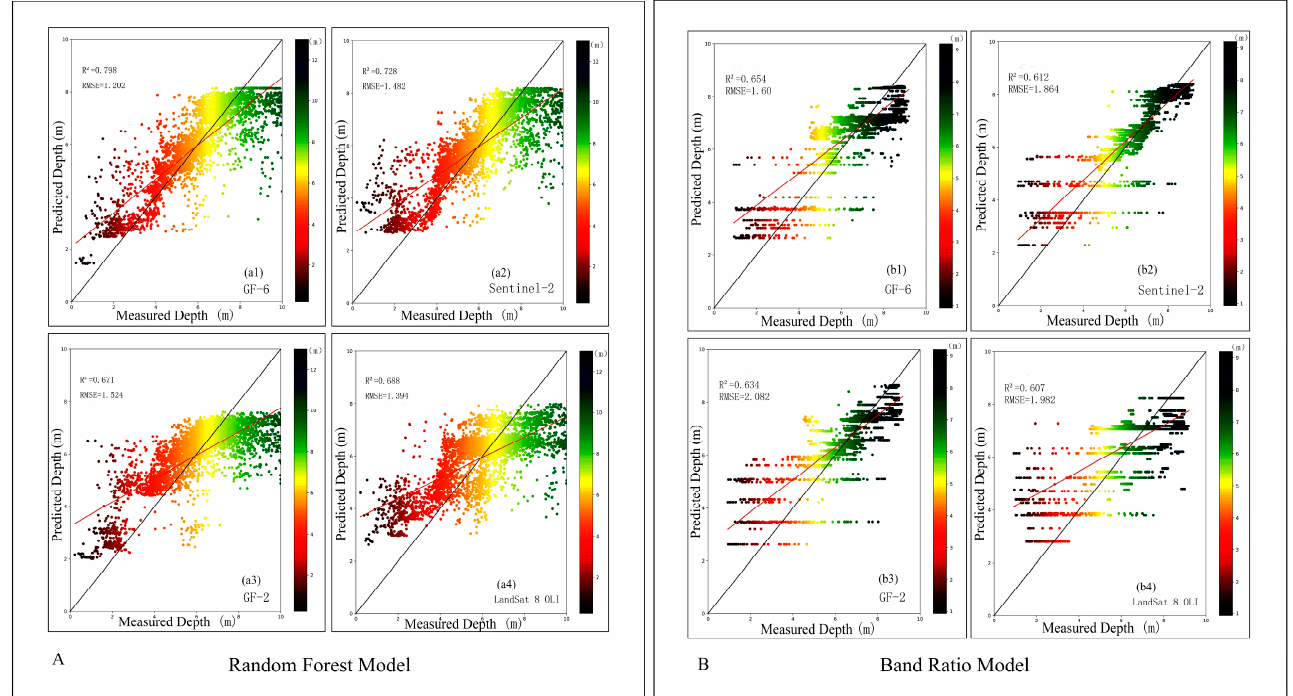
Figure 7. Correlation between water depth inverted by different images of different models and measured water depth: ( A ) is Random Forest Model, ( a1 ) GF-6, ( a2 ) Sentinel-2B, ( a3 ) GF-2, ( a4 ) Landsat 8 OLI; ( B ) is Band Ratio Model, ( b1 ) GF-6, ( b2 ) Sentinel-2B, ( b3 ) GF-2, ( b4 ) Landsat 8 OLI.